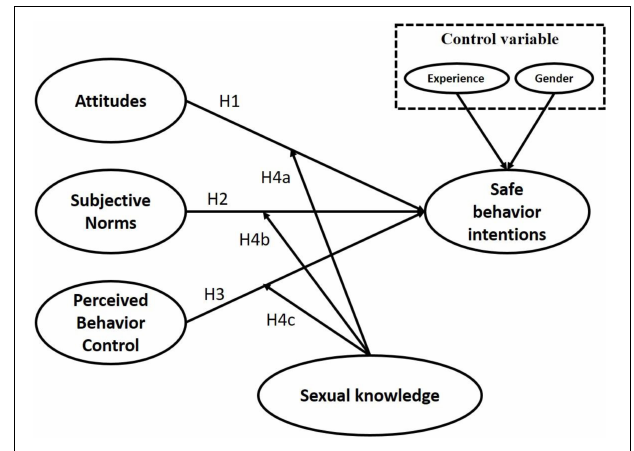
FIGURE 1 | Research